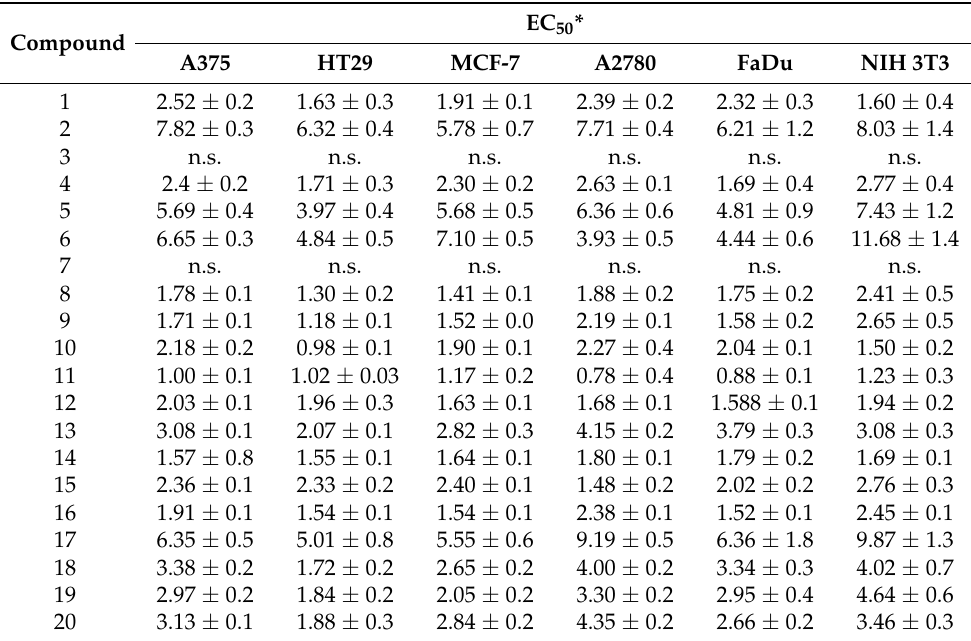
Table 1. Cytotoxicity * of compounds 1 – 20 against the human cancer cell lines A375, HT29, MCF-7, A2780, FaDu, and non-malignant mouse fibroblasts NIH 3T3.